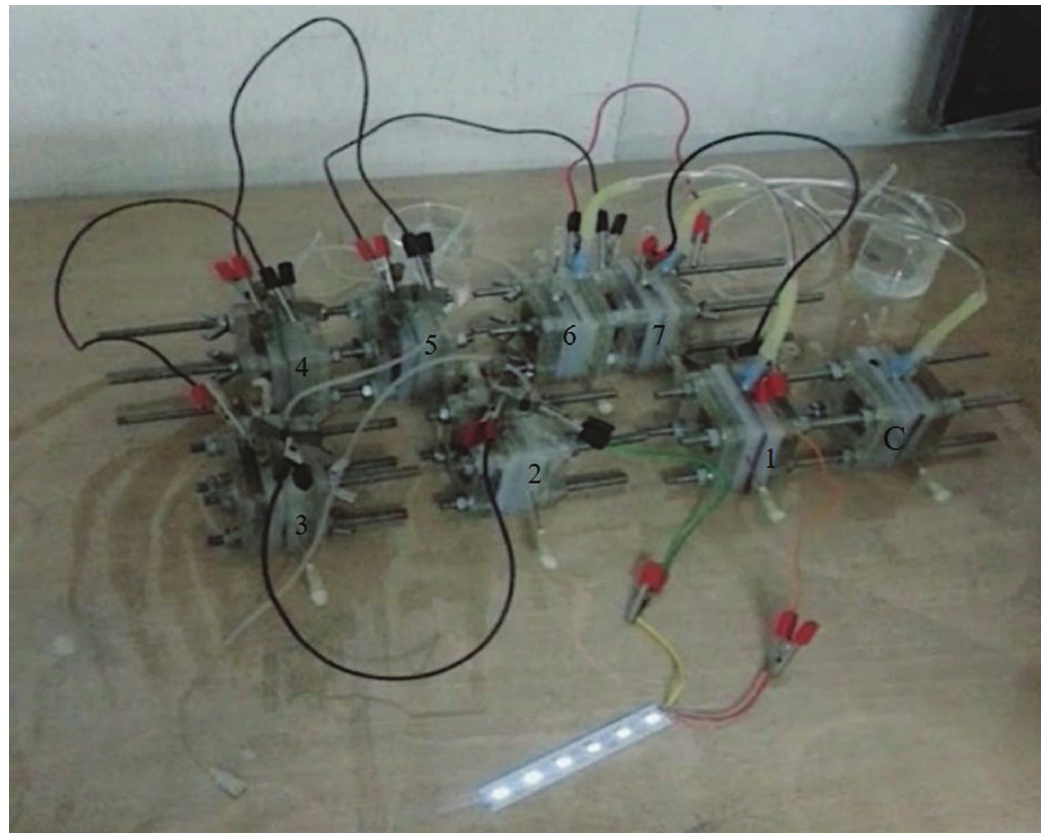
Fig. 9 – A 4 V LED light strip powered by seven CW-MFCs connected in